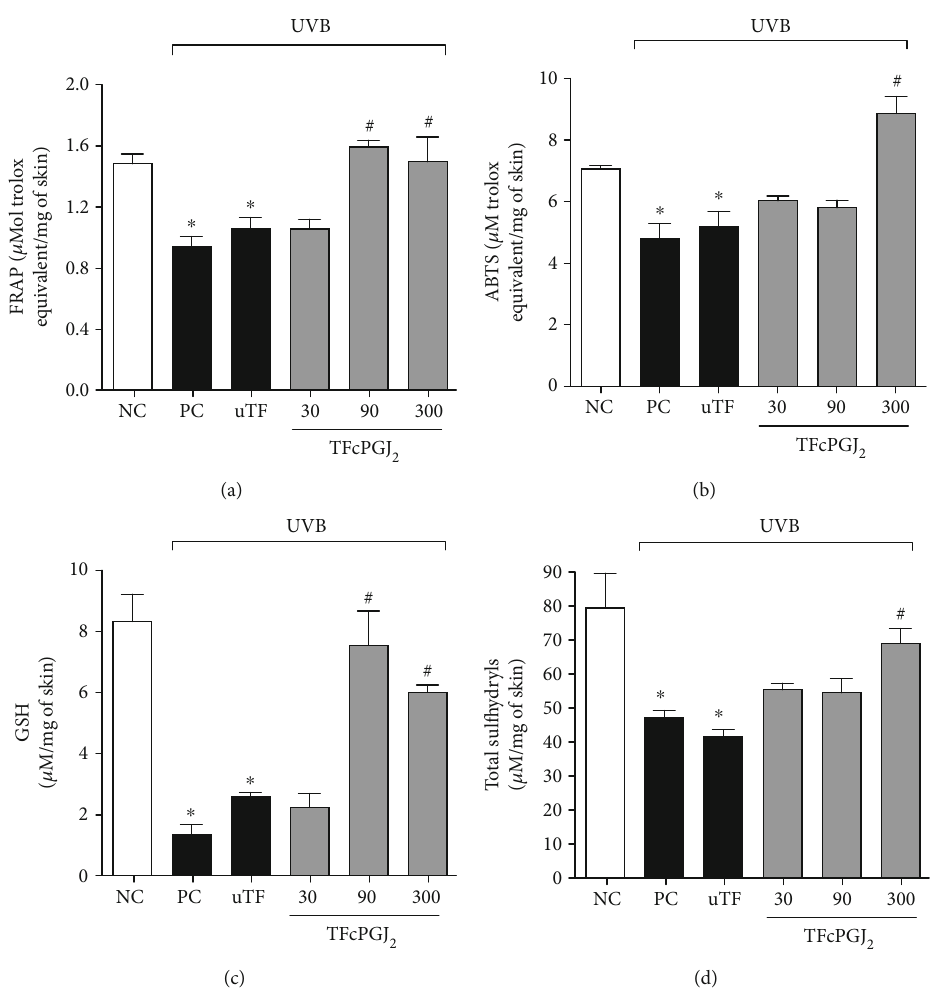
Figure 3: Topical formulation containing 15d-PGJ (TFcPGJ ) inhibits the depletion of endogenous antioxidants by UVB irradiation. The 2 2 antioxidant capacity was measured using FRAP (a), ABTS (b), GSH (c), and total sulfhydryl (d) assays in samples collected 12 h after the end of irradiation. NC: negative control; PC: positive control; uTF: unloaded topical formulation. Bars are means ± SEM of 6 mice per group and are representative of two separate experiments. One-way ANOVA followed by Tukey ’ s test. ∗ p < 0 : 05 versus the negative control group; # p < 0 : 05 versus UVB-stimulated